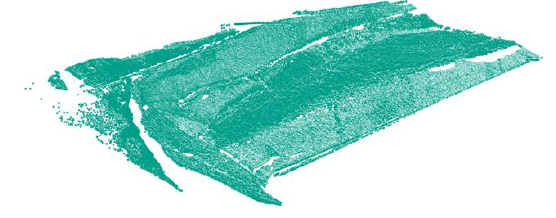
Figure 12. Result for the merging